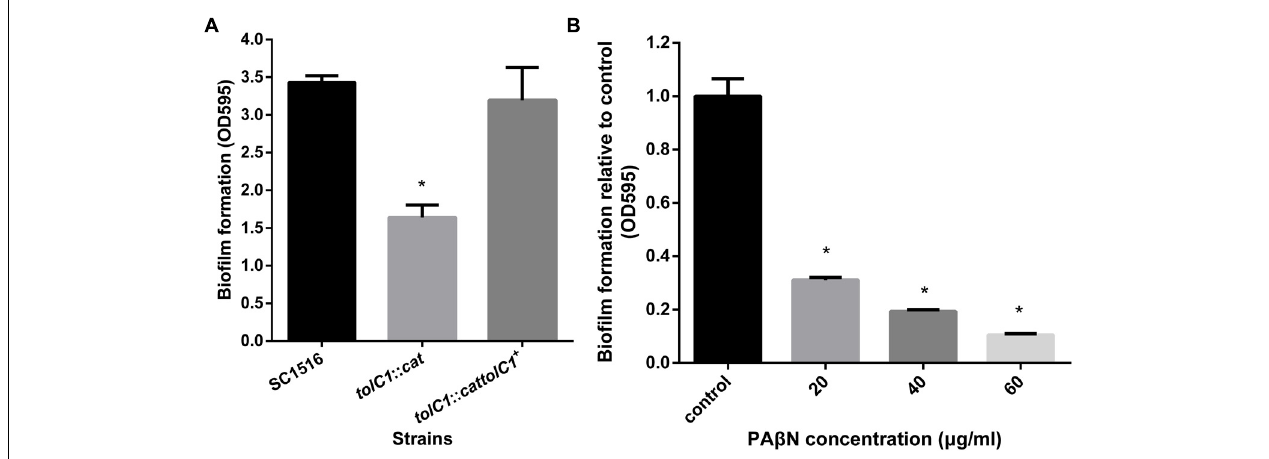
FIGURE 4 | The loss of TolC1 or the addition of PA β N impaired biofilm formation in A. pleuropneumoniae . (A) The tolC1 :: cat had significantly reduced ability to form biofilms. (B) PA β N inhibited biofilm formation of wild-type strain SC1516 in a dose-dependent manner. Data indicate the mean of three independent experiments performed in duplicates and error bars show SDs. Asterisks indicate statistical significance using one-way ANOVA ( ∗ P < 0.05).